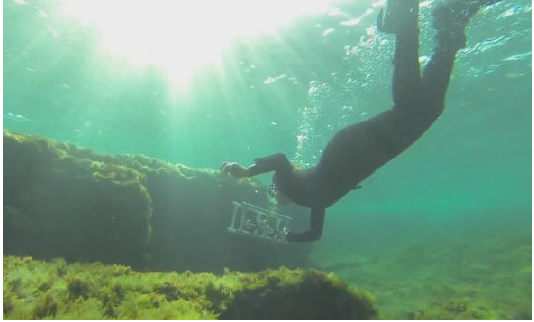
Figure 2. First prototype of ScubaLibre